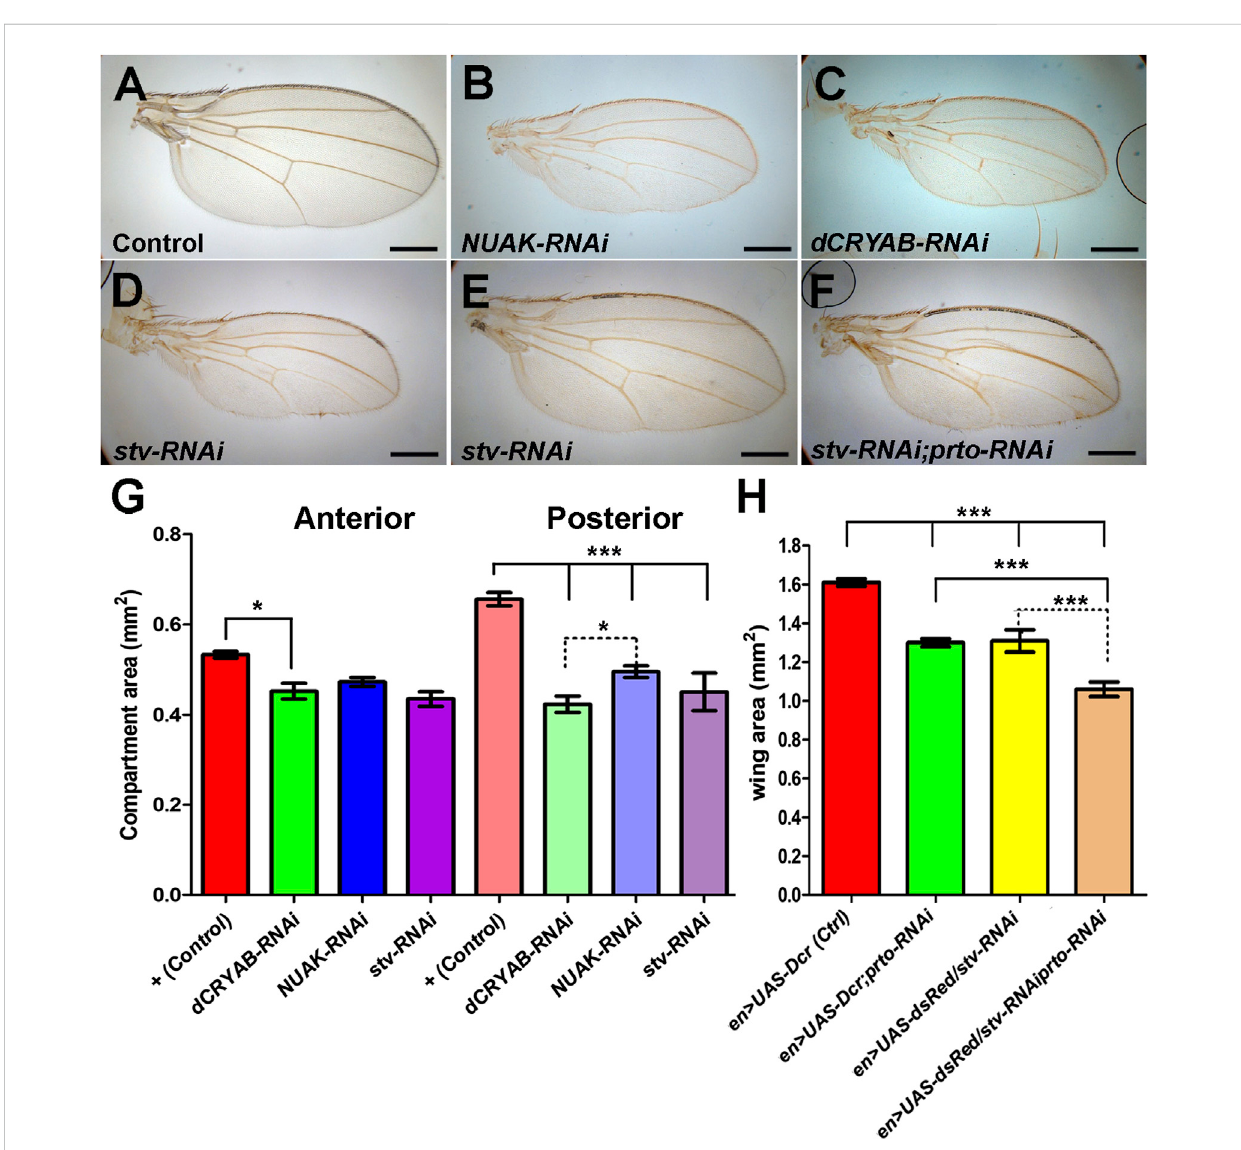
FIGURE 8 CASA members interact with prto for proper wing growth. Adult wings of Control (A) , NUAK-RNAi (B) , dCRYAB-RNAi (C) and stv-RNAi (D) knockdown male fl ies using en > UAS-dsRed driver. (E,F) Adult female wing of a single stv -RNAi knockdown (E) and double prto-RNAi and stv-RNAi knockdown (F) using en > UAS-dsRed driver. (G) Area of anterior and posterior compartments of adult male wings showing that knocking down CASA members, NUAK , dCRYAB , stv ,using en > UAS-dsRed driverproducesareductioninsizeoftheposteriorcompartment.1wayANOVAwithBonferroni posttest. n =24 – 29,errorbarsrepresent95%CI***= p < 0.0001,**= p < 0.001,*= p < 0.05. (H) Areameasurementsofentirefemaleadultwingsshowing similar reductions of wing size provoked by single prto , and stv RNAi knockdowns. Further wing size reduction is achieved in the double